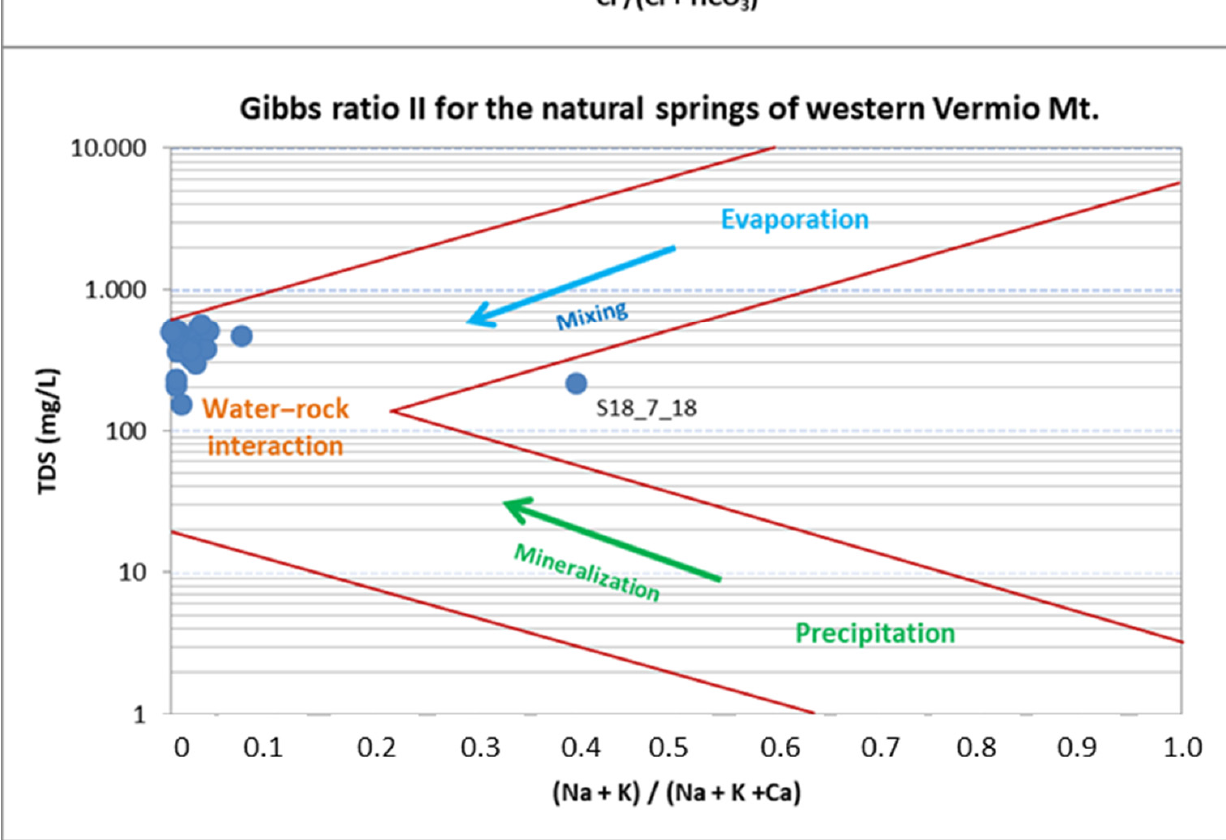
Figure 14. Gibbs diagrams of the natural springs in western Vermio Mt.